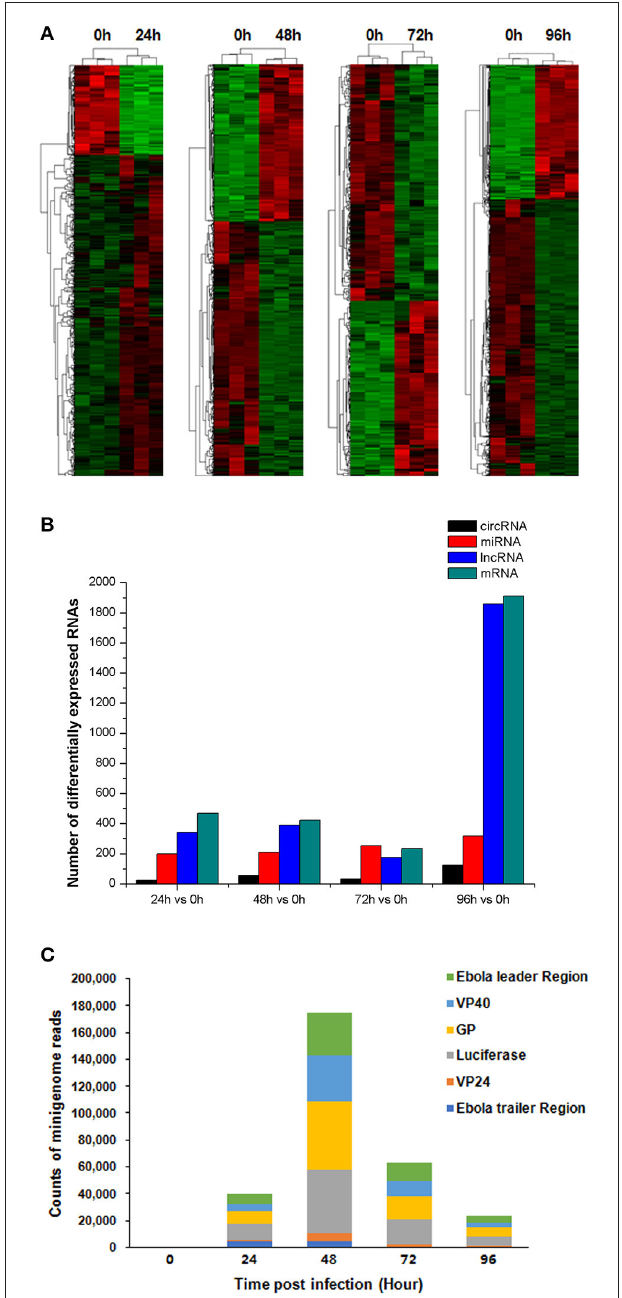
FIGURE 3 | RNA expression profile and hierarchical clustering analysis. (A) Hierarchical clustering analysis. The Limma algorithm was applied to filter differentially expressed lncRNAs, circRNAs, mRNAs and miRNAs at four time points (24, 48, 72, and 96h) compared with the 0-h time point post virus infection ( P < 0.05, fold change > 2). (B) Differentially expressed RNA numbers. The numbers of differentially expressed circRNAs, lncRNAs, miRNAs, and mRNAs are indicated at four time points compared with the 0-h time point. (C) Minigenome read numbers. We searched the vRNA sequences of trVLPs in a partial profile that was not mapped to the human genome. The reads at five time points included the following sequences: Ebola leader region, VP40, GP, VP24, Ebola trailer region and Renilla luciferase. Read numbers at each time point represent the averages of triplicate